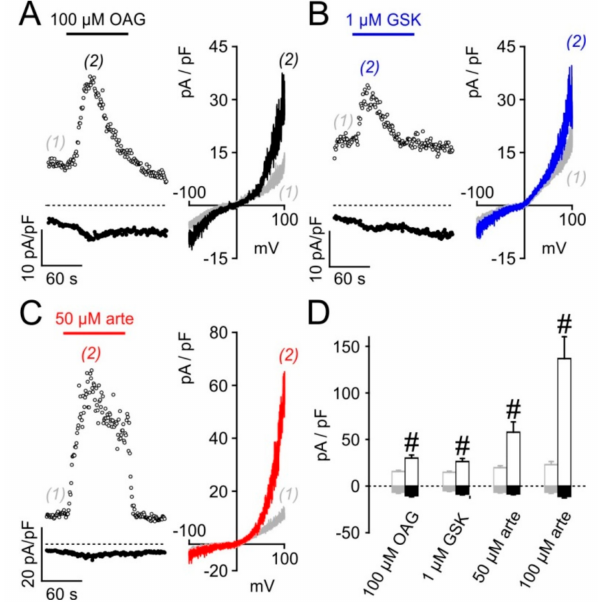
Figure 8. Electrophysiological whole-cell recordings of artemisinin-induced TRPC3-like currents in PC12 cells. Current densities in PC12 cells were recorded at + 100 mV (upper traces) and –100 mV (lower traces) as described in Figure 4A during the application of 100 µ M OAG ( A ), 1 µ M GSK-1702934A (GSK; B ), or 50 µ M artemisinin (arte; C ). Time courses of current densities (left panels) and I / V curves taken at the indicated time-points (right panels) are depicted. (D) Statistical analysis of outward (open bars) and inward current densities (filled bars) in 11–15 PC12 cells before (grey) and during the exposure to the indicated activators (black). #: statistically significant di ff erence of both outward and inward current densities compared to the respective basal